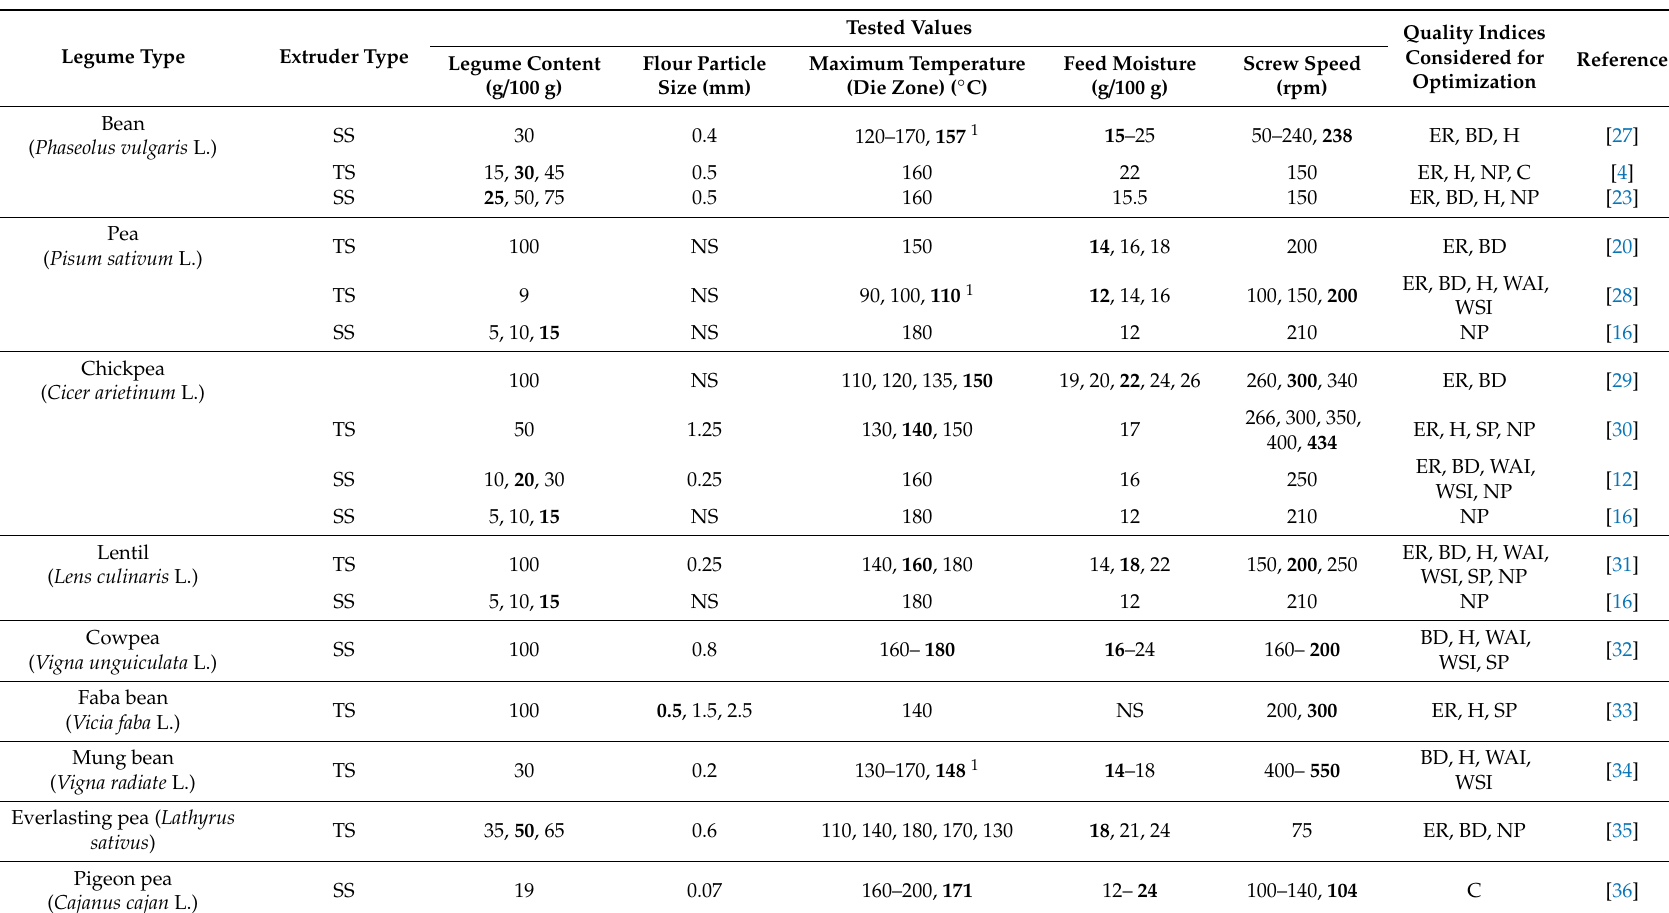
Table 1. The main results of the studies aimed at identifying the optimal processing conditions for the extrusion cooking of legumes. The optimal values for each parameter, among the tested ones, are those highlighted in